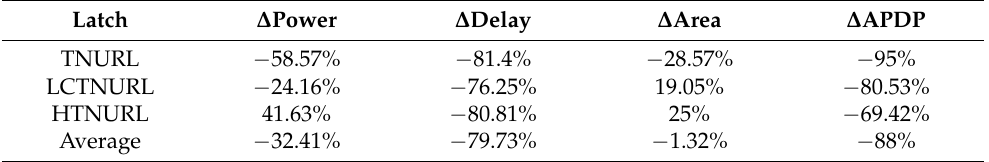
Table 3. Relative changes of performance and area cost comparisons of TNU-recoverable latches.